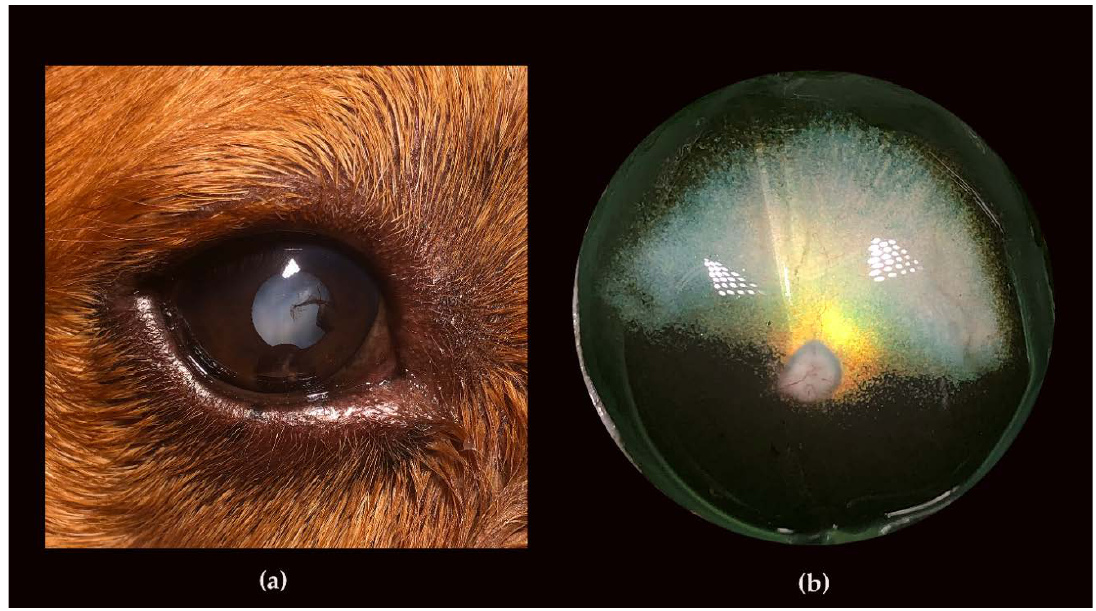
Figure 4. Iridociliary cysts and fundus imaging of the affected male (GR01). ( a ) Iridociliary cysts both at the posterior side of the iris and free-floating in the anterior chamber were seen in both eyes of the affected male (GR01). Pigment and remnants of ruptured cysts were seen on the anterior capsules of the cataractous lenses. ( b ) The eyecup of the affected male (GR01), postmortem. Bright tapetal hyperreflection is seen close to the optic nerve head (ONH), whereas the rest of the tapetum is faintly colored. The retinal vessels, including the larger venules, are almost impossible to follow.